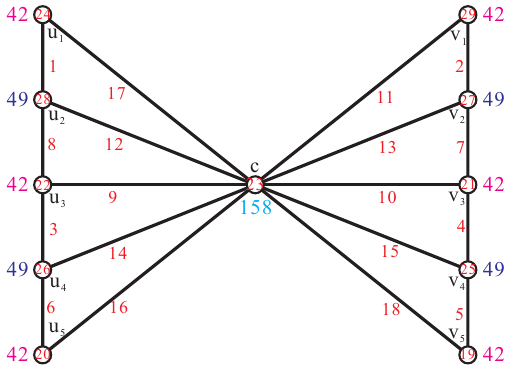
Figure 5. The local antimagic total labeling of B 5,5 .